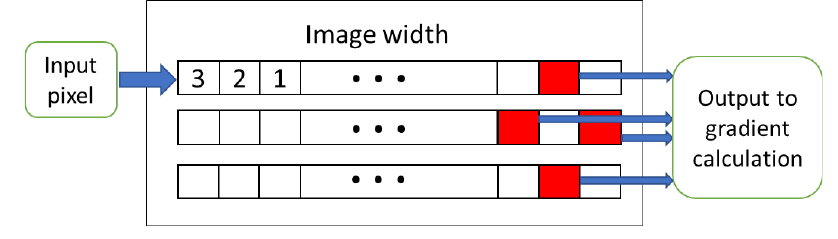
Figure 6. Line buffers in the deserializer module.